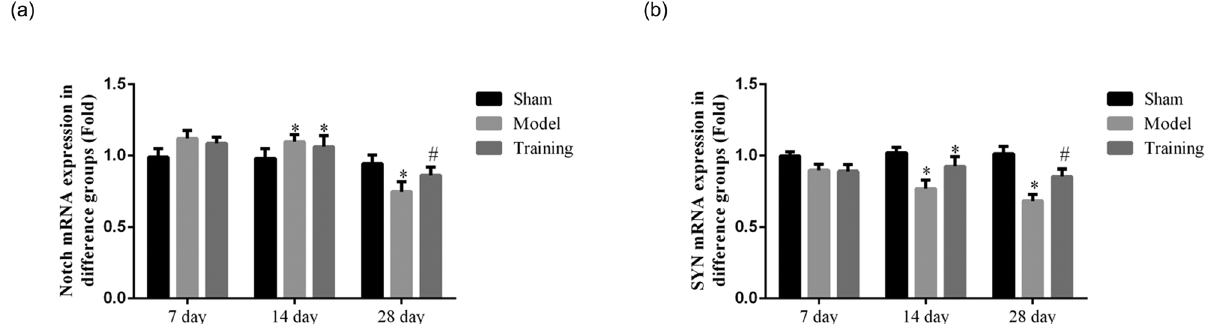
Figure 2: The Notch and SYN mRNA expressions in di ff erent groups by RT - qPCR assay. Sham: Sham group; Model: nerve injuries in CCI rat model; Training: nerve injuries in CCI model rats that were treated with rehabilitation training exercises. ( a ) The Notch mRNA expression in di ff erent groups; * P < 0.05 compared with the Sham group; # P < 0.05 compared with the Model group. ( b ) The SYN mRNA expression in di ff erent groups; * P < 0.05 compared with the Sham group; # P < 0.05 compared with the Model